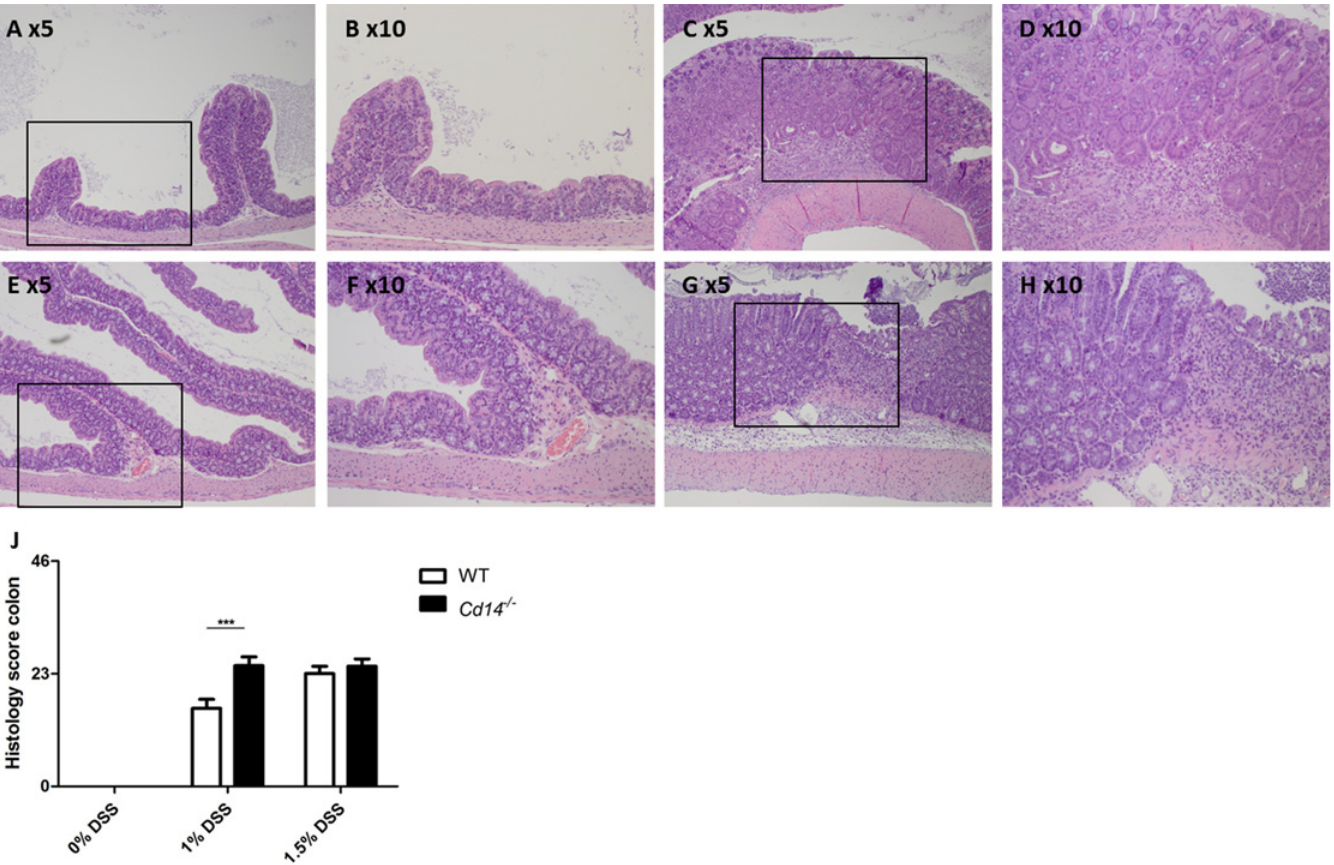
Fig 1. Intestinal inflammation induced by DSS-treatment. Hematoxylin and eosin staining of colon tissue obtained from (A-D) wild-type and (E-H) Cd14 - deficient mice treated with 1% DSS for seven days (C-D and G-H, respectively). Untreated controls (A-B and E-F) did not show any signs of inflammation. Colitis was characterized by the presence of mixed cell infiltrates, hyperplasia, abnormal crypt architecture, edema and erosions (see boxed magnifications D and H). Original magnification 5x and 10x. Histological score quantifying the alterations observed in the colon